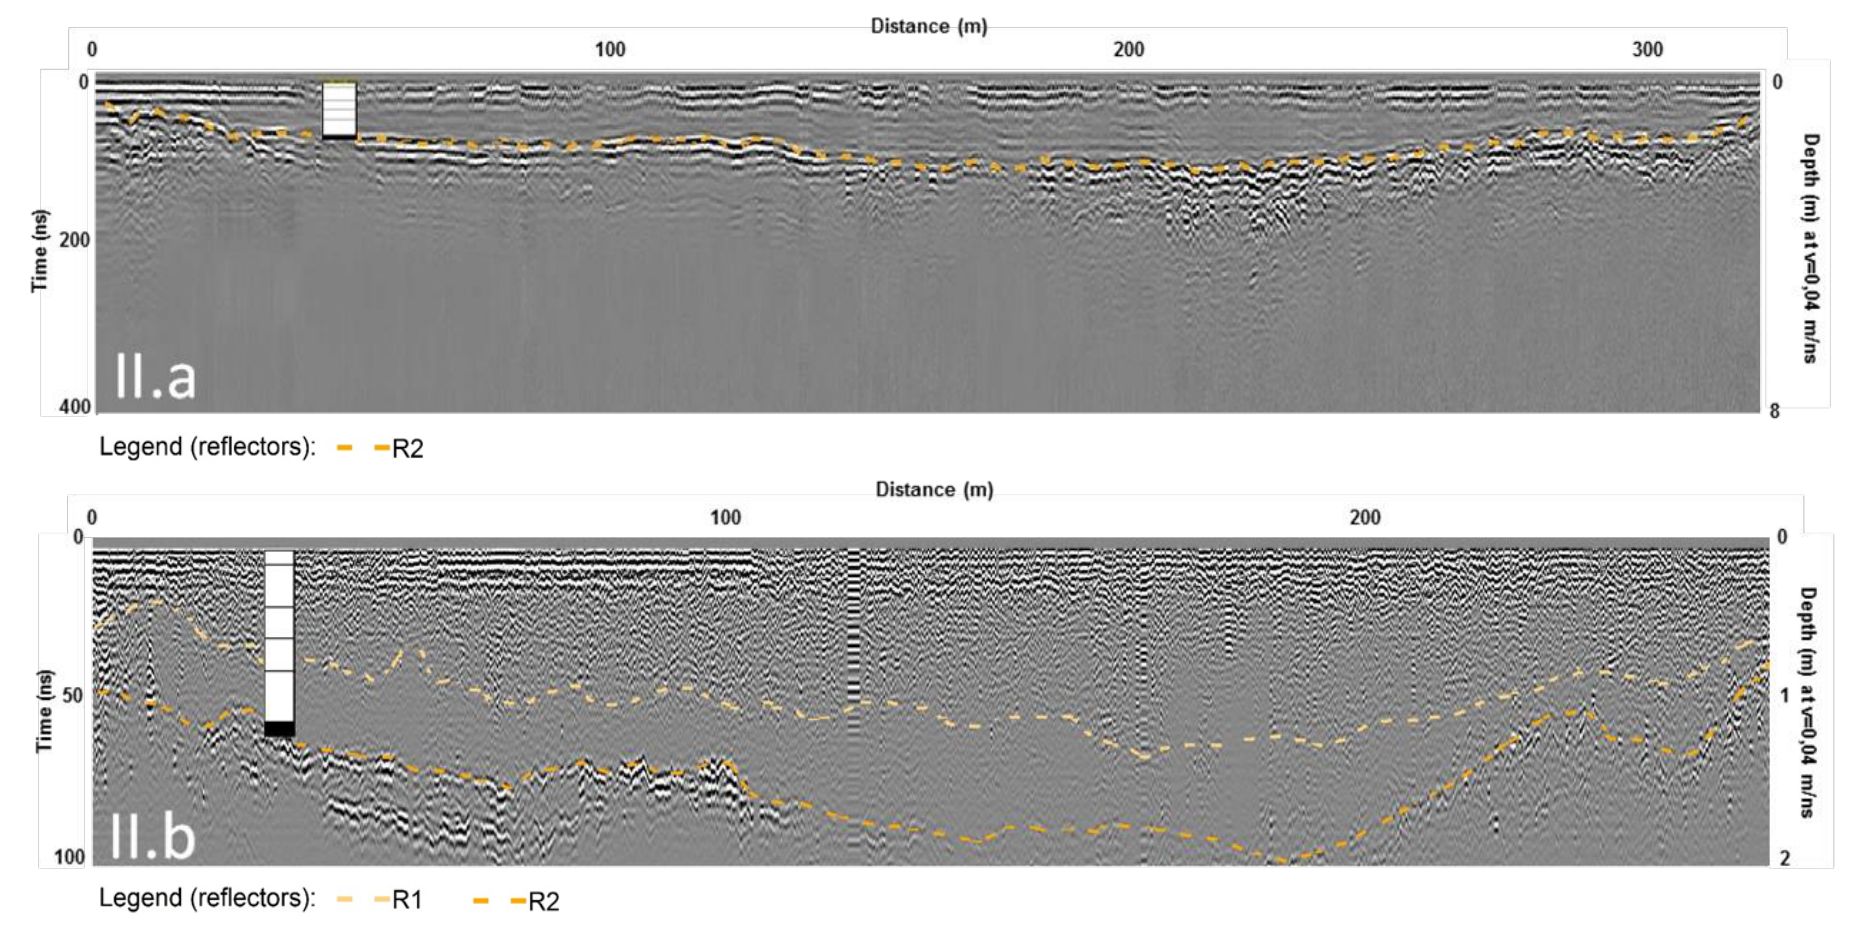
Figure 8. Peat Bog II: example radargrams produced using the 100 MHz antenna (above) and the 500 MHz antenna (below). The transect selected includes the open core (see Figure 4 for more information). The dashed lines indicate interpreted reflections in the GPR